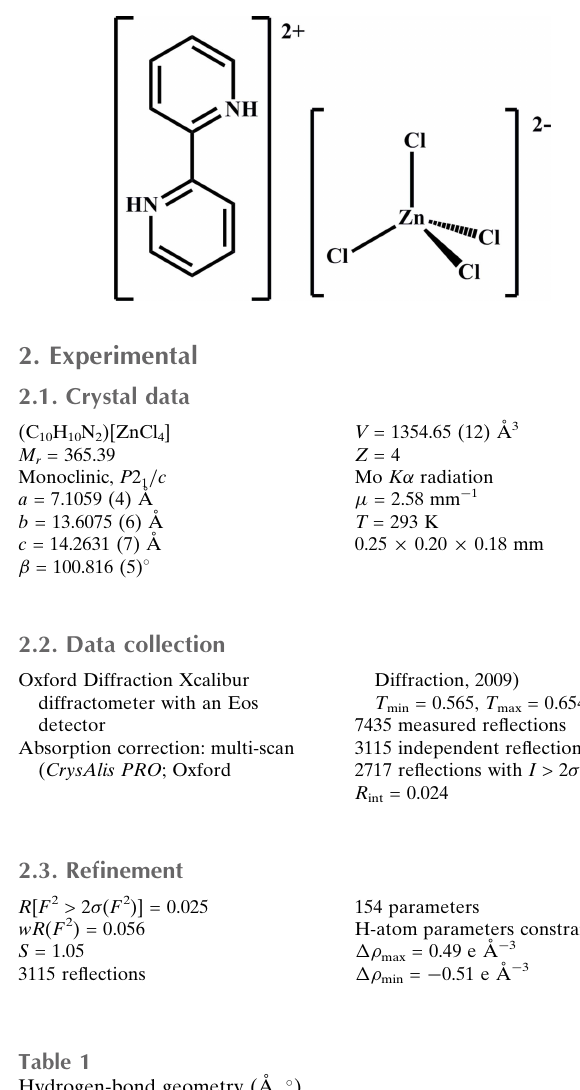
Hydrogen-bond geometry (A˚ , (cid:2)